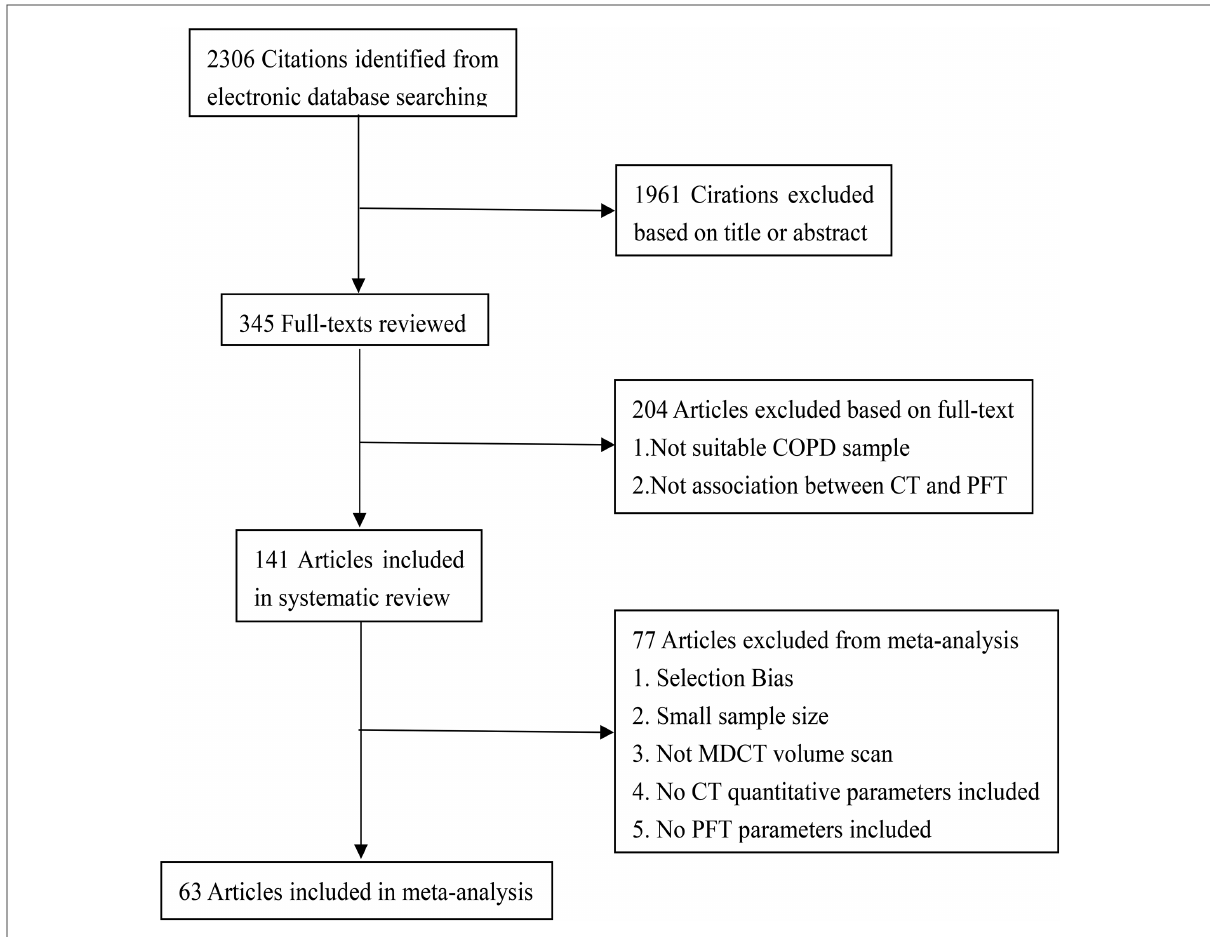
FIGURE 1 Flowchart of literature review and selection. COPD, chronic obstructive pulmonary disease; PFT, pulmonary function test; MDCT, multi-detector computed